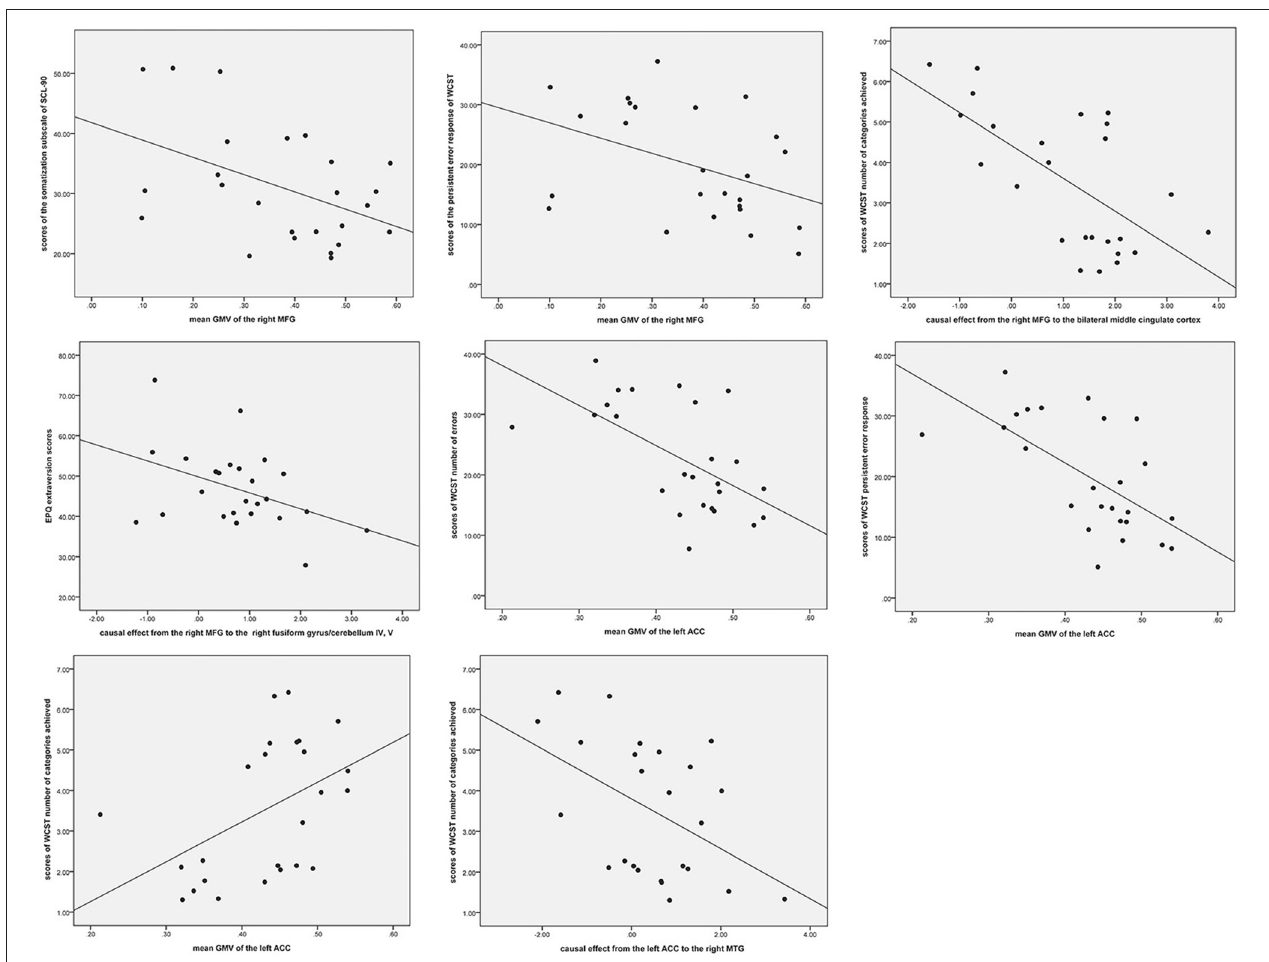
FIGURE 5 | Correlations between abnormal GMV or causal effects and clinical variables in patients with somatization disorder. GMV, gray matter volume; ACC, anterior cingulate cortex; WCST, Wisconsin Card Sorting Test; WCST-Pre, persistent error response of WCST; MFG, middle frontal gyrus; MTG, middle temporal